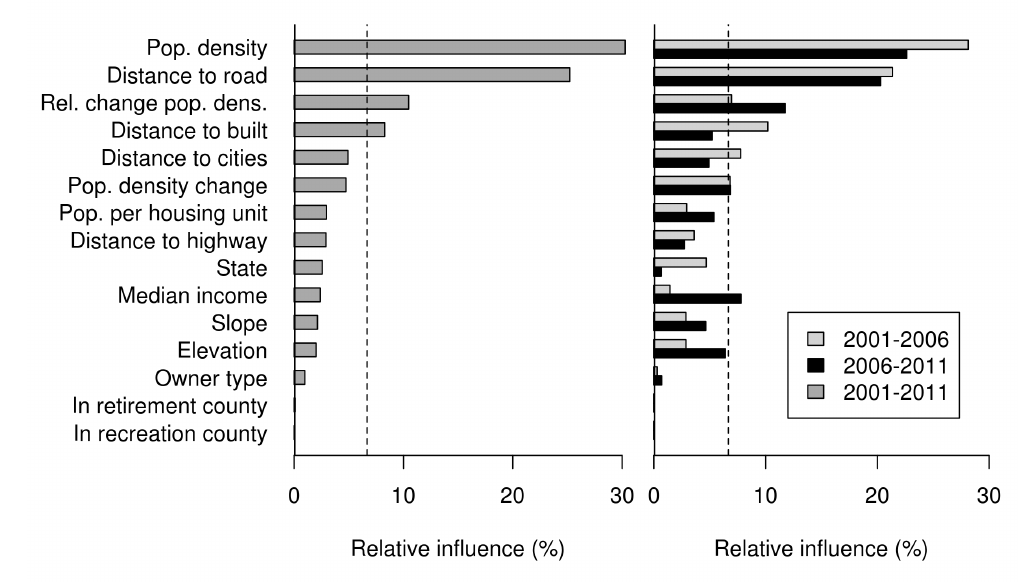
Figure 2. Percent of the relative influence of independent variables in the BRT models of the development probability for the full interval 2001–2011 and for the time intervals 2001–2006 and 2006–2011. The dashed vertical line shows the influence level expected by chance